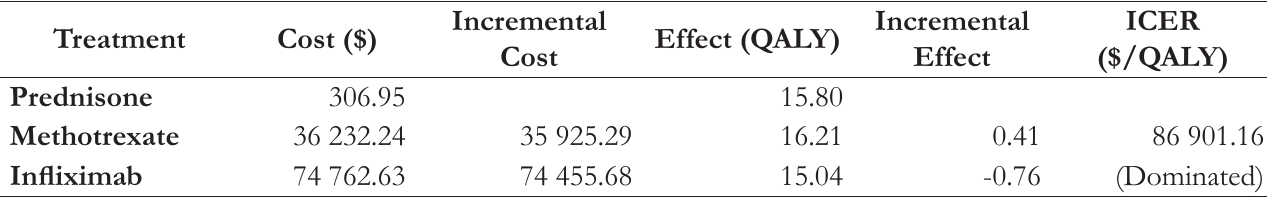
Table 2. Discounted Expected Results of the Cost-effectiveness Analysis Comparing Methotrexate and Infliximab to Prednisone at Baseline for Treating Posterior Uveitis and